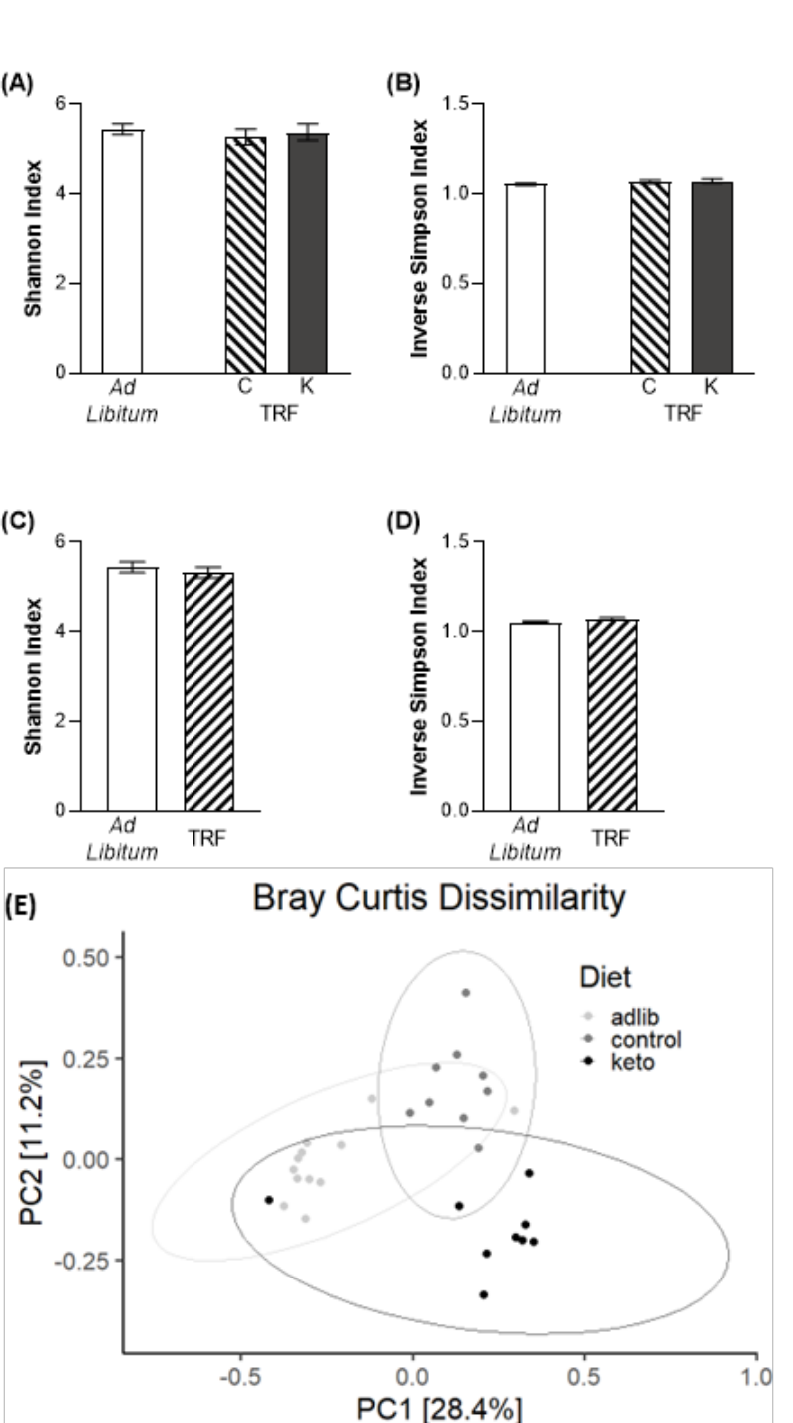
Figure 5. Beta, but not alpha, diversity differed across dietary paradigms. Neither the Shannon or Inverse Simpson indices of alpha diversity differed across ( A , B ) macronutrient or ( C , D ) feeding paradigm groups. ( E ) Conversely, beta diversity was different across both diet groups and feeding paradigms. Data in ( A – D ) are group means ± 1 SEM; PC = principal component.